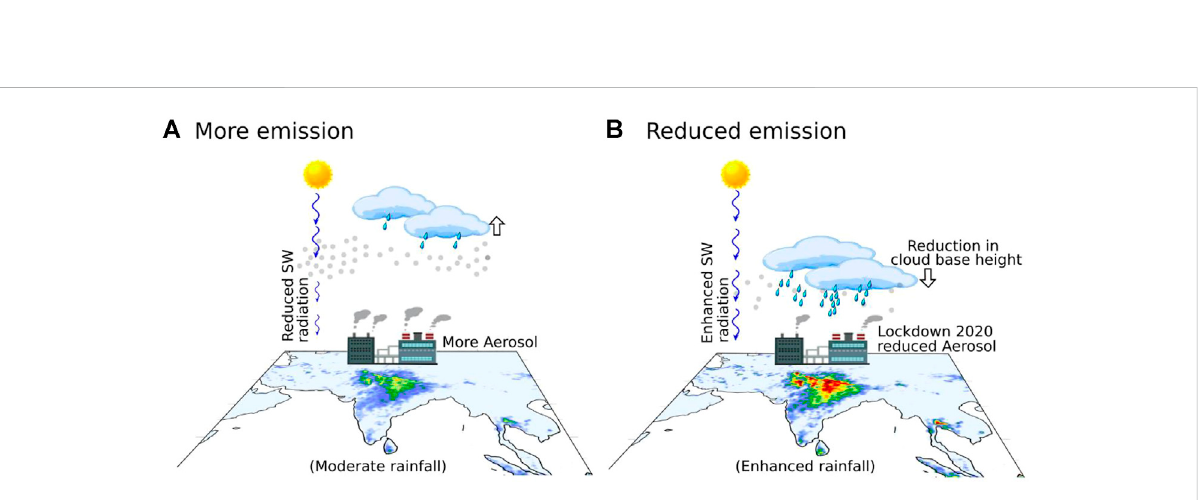
FIGURE 6 Schematic of the possible mechanism behind the COVID-19 pollution reduction and observed changes in cloud and precipitation over South Asia. (A) shows a normal emission condition and (B) explains the reduced emission (COVID-19)